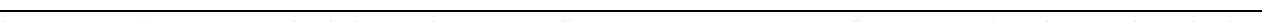
Fig. 4 SHP2 translocates into mitochondrial matrix during NLRP3 in fl ammasome activation. a Immuno fl uorescence analysis of SHP2 and mitochondria from bone marrow-derived macrophages with untreated (medium) or ATP (5 mM, 15 min), or MSU (500 µ g ml − 1 , 2 h) or Nigericin (10 µ M, 2 h) treatment. Scale bar, 5 µ m. b Immunoblot analysis of mitochondrial and cytosolic components of THP-1-derived macrophages treated with ATP (5 mM) for indicated times. c Immunoblot analysis of SHP2 location in mitochondria from THP-1-derived macrophages. Cells were treated with 5 mM ATP for 30 min,